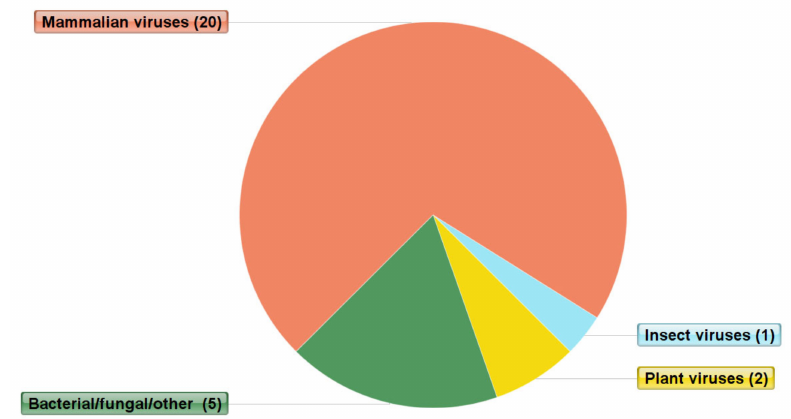
Figure 2. Di ff erent types of viruses from 12 faecal samples categorized based on host organism.